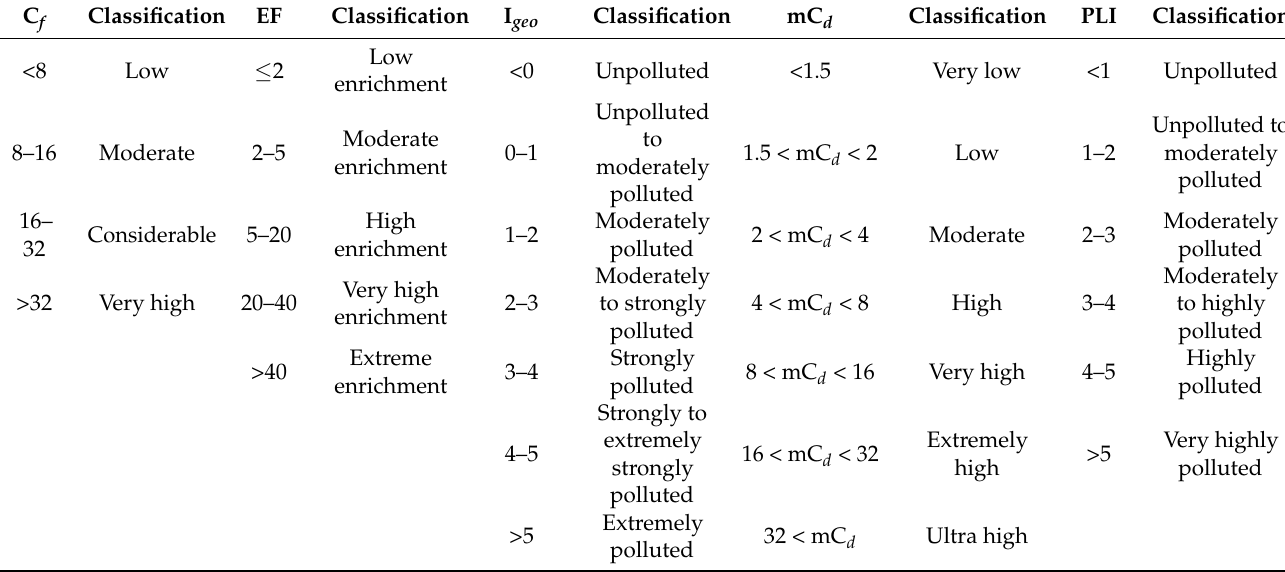
Table 1. Summary of the classification categories of sediment contamination derived from the different applied indicators.